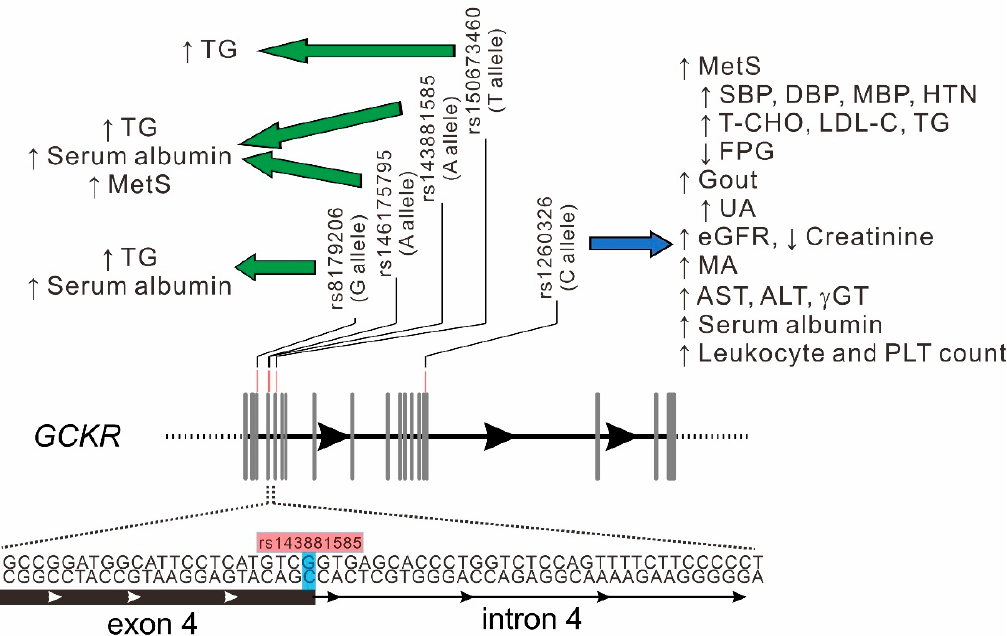
Figure 5. Genomic structure of GCKR variants and their association with various phenotypes/dis- eases. Green arrow: association with low-frequency and rare GCKR variants. Blue arrow: associa- tion with rs1260326 genotypes. Abbreviations: MetS, metabolic syndrome; MA, microalbuminuria; PLT, platelet. Other abbreviations as in Figure 1 and Table